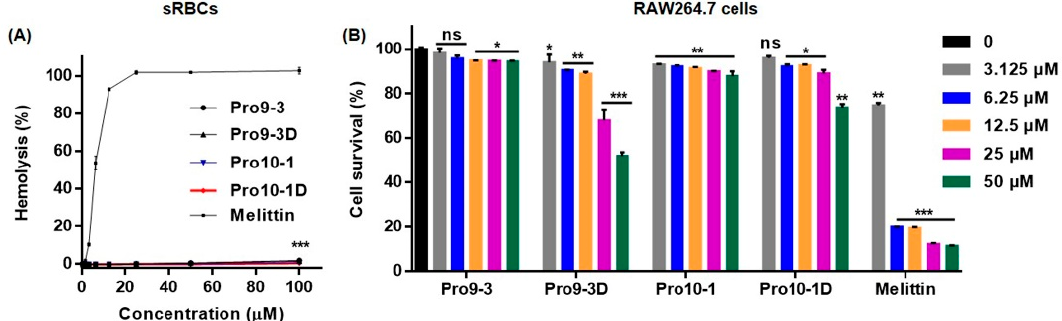
Figure 2. Cytotoxic effects of Pro9-3 and its analogs: ( A ) dose–response curves for sheep red blood cell (sRBC) hemolysis induced by peptides and ( B ) dose-dependent (0–50 µM) cytotoxicity of the peptides against mouse macrophage RAW264.7 cells for 24 h. Melittin was used as a control. The values are expressed as the mean ± SEM of three independent experiments and are statistically significant at * p < 0.05, ** p < 0.01, and *** p < 0.001; ns, not significant (by one-way ANOVA , Tukey’s post hoc test) .